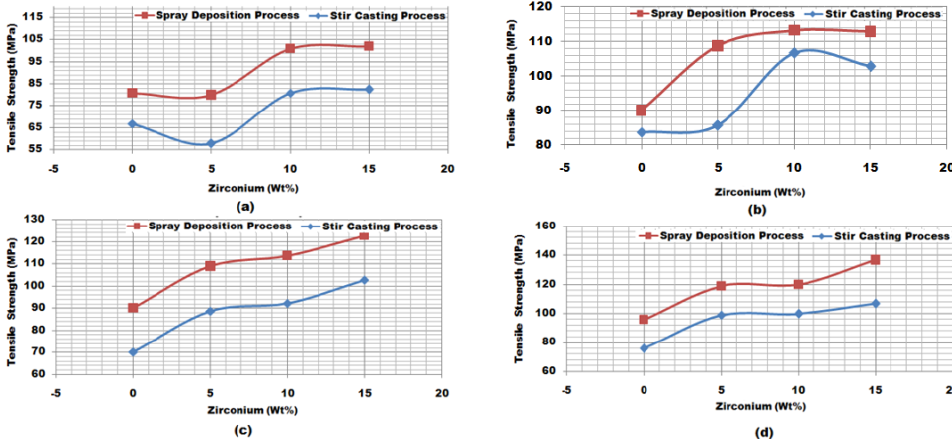
Figure 19. Tensilestrength (0.05% error) experimental plot at different processing techniques of Si-Al alloy matrix reinforced with ZrO 2 particulates for ( a ) 10% ( b ) 11% ( c ) 12% ( d ) 13 wt. % Si.